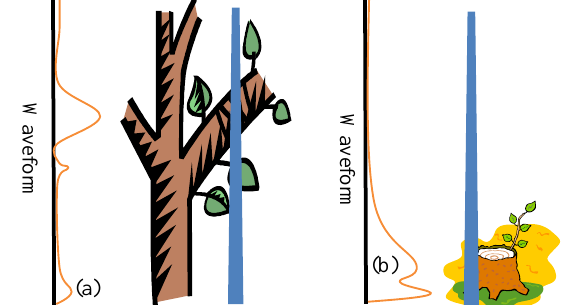
Figure 1. Interpretation of difficult-to detect echoes, (a) weak echo due to the loss of laser energy, (b) overlapped echoes